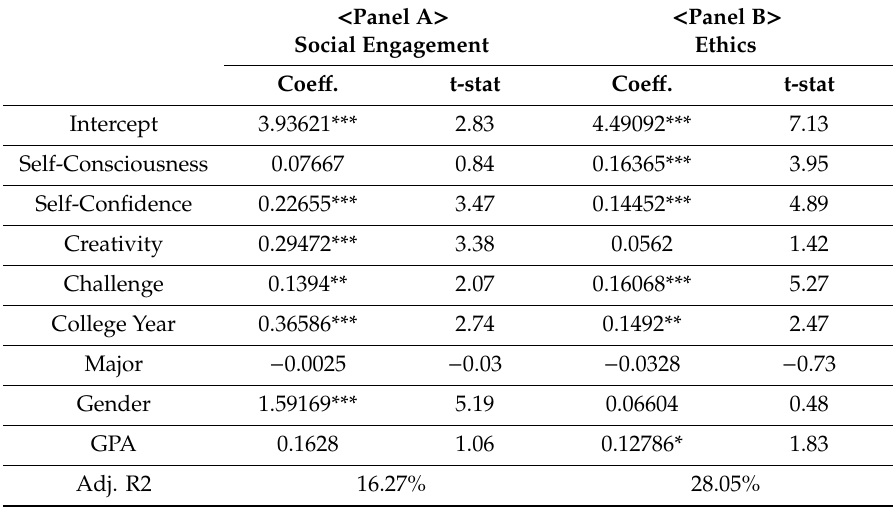
Table 4. E ff ects of Self-Actualization on Creating Shared Value (CSV).